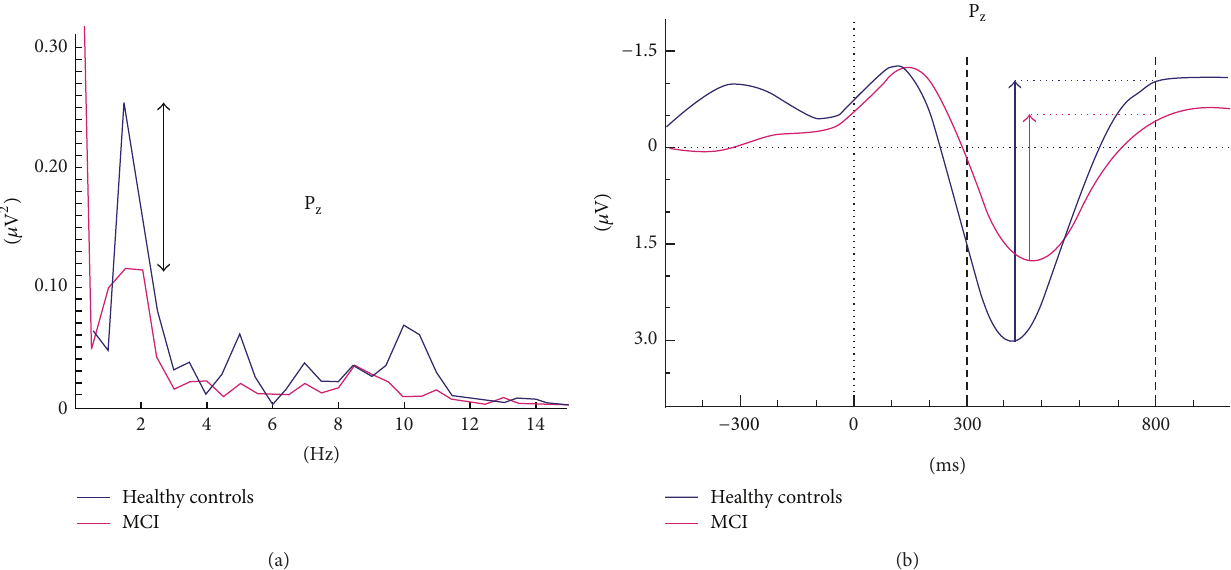
Figure 1: Example of analysis in event-related power spectra and delta response measurements. (a) Superposition of event-related power spectrum of mild cognitive impairment (MCI) ( 𝑛 = 22 ) and healthy subjects ( 𝑛 = 21 ). (b) Measurement of peak-to-peak